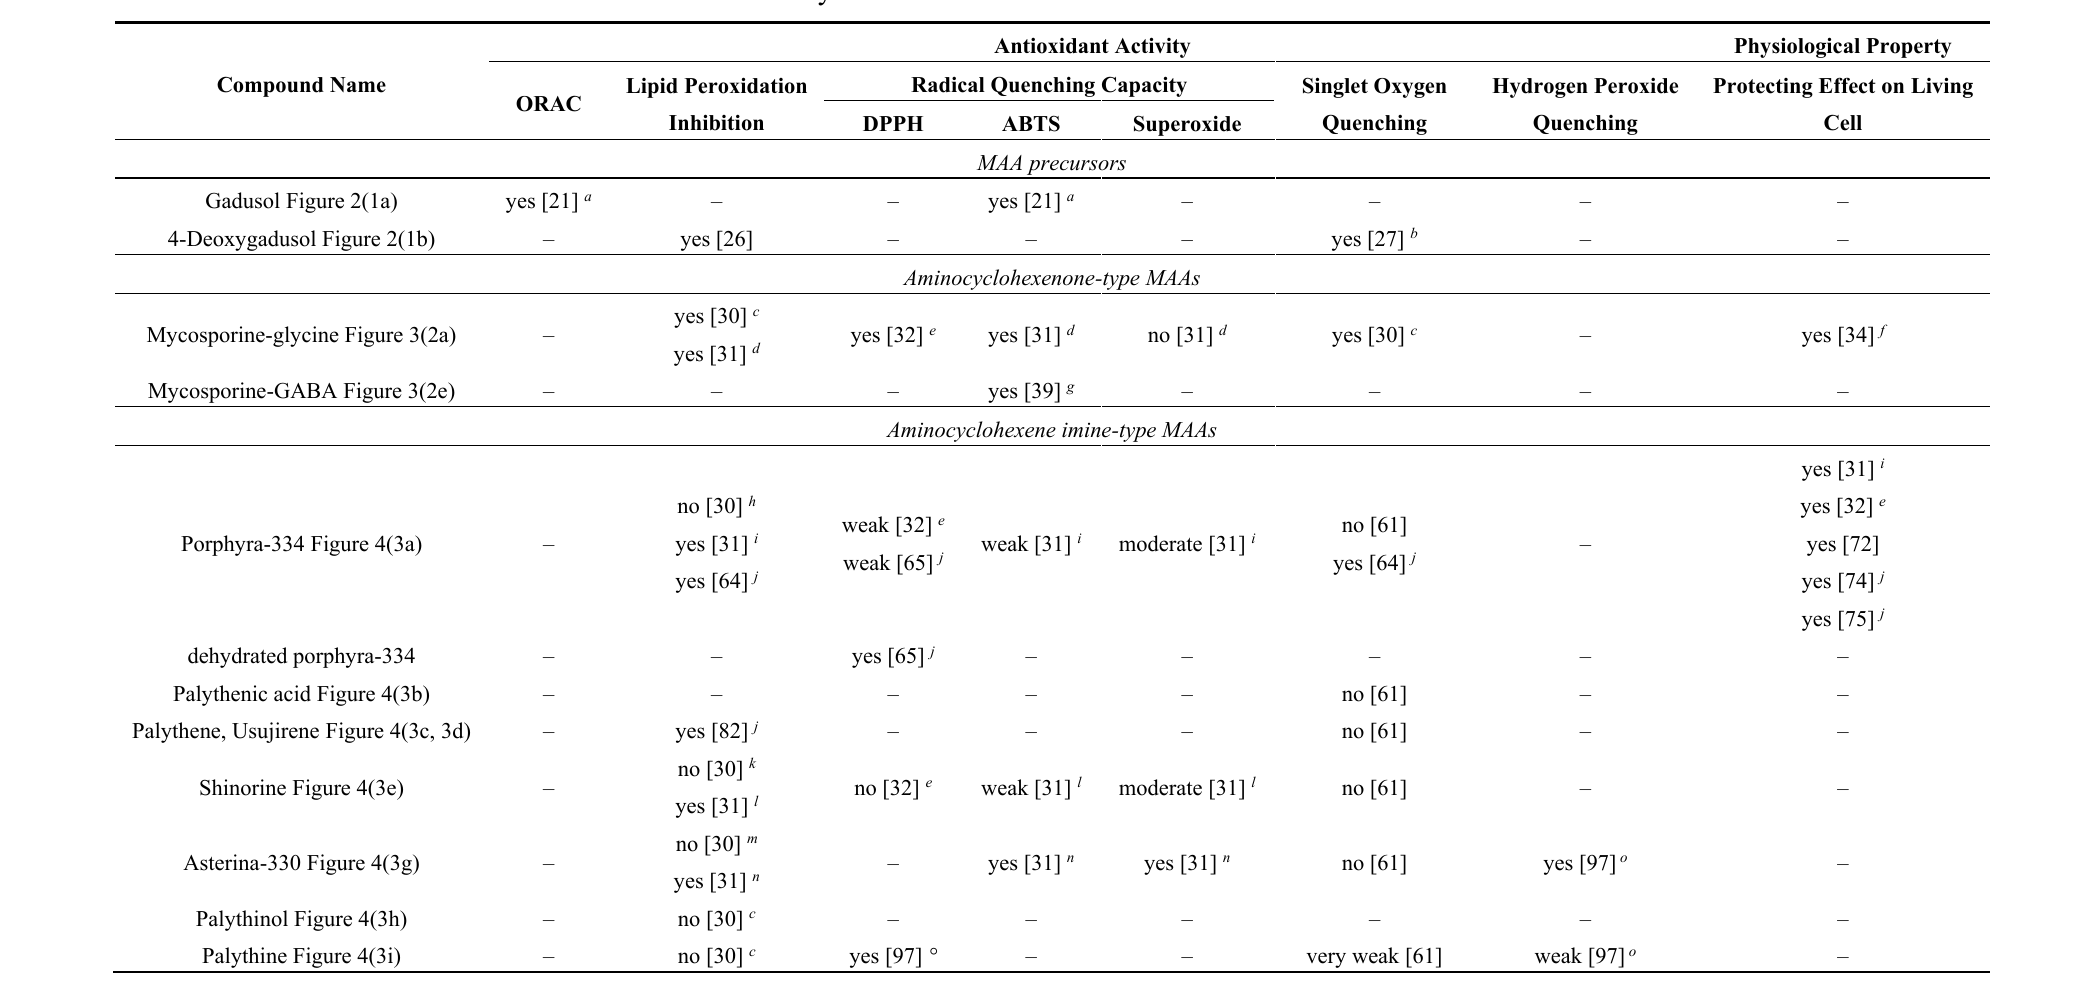
Table A1. Summary of the antioxidant activities of various MAA